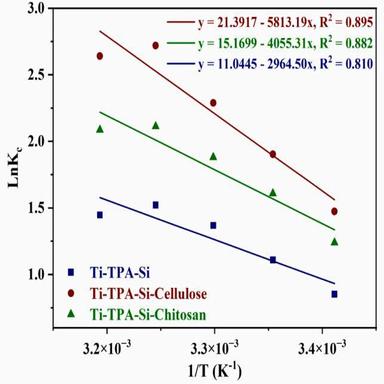
Van't Hoff plot for the adsorptive removal of TTC by Ti-TPA-Si, Ti-TPA-Si-C, and Ti-TPA-Si-CS.